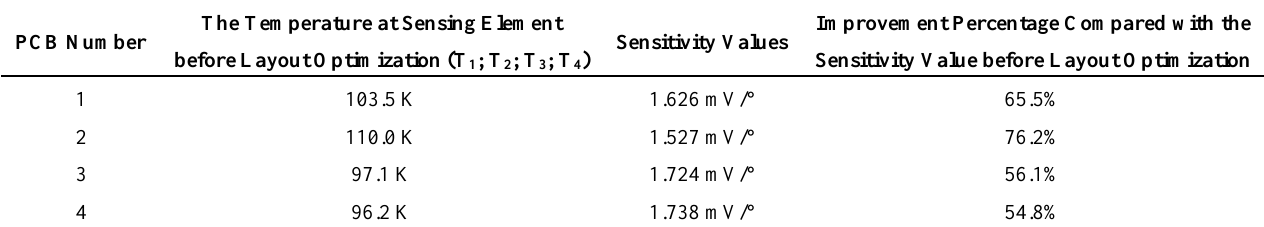
Table 2. Layout optimization before and after comparison for the sensor sensitivity